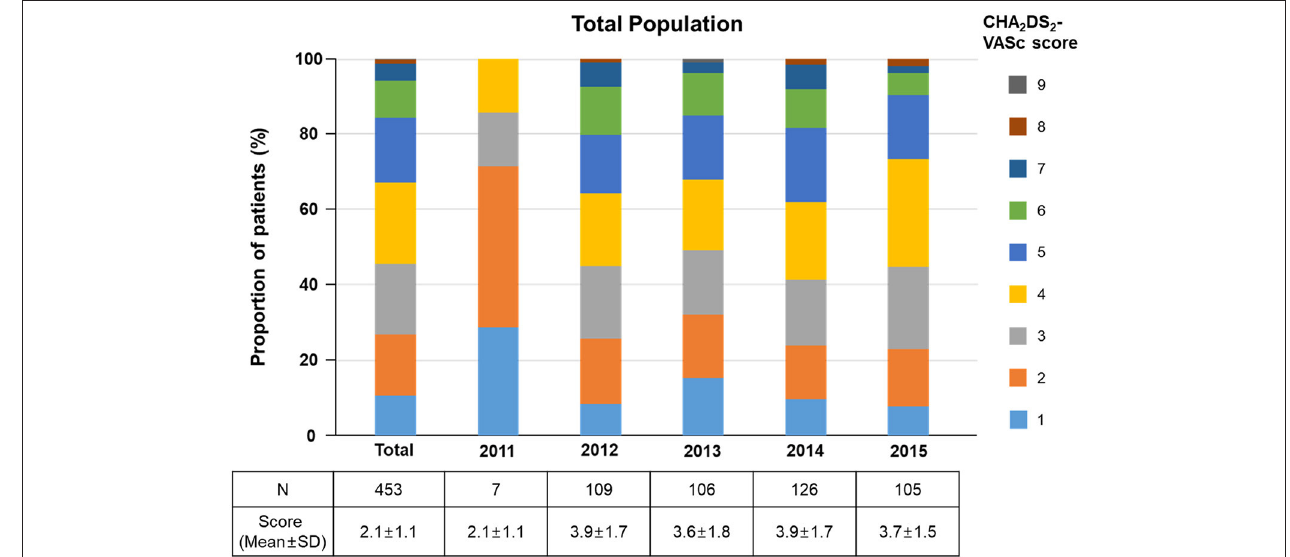
FIGURE 3 | The trend of detailed distributions of the CHA2DS2-VASc scores.